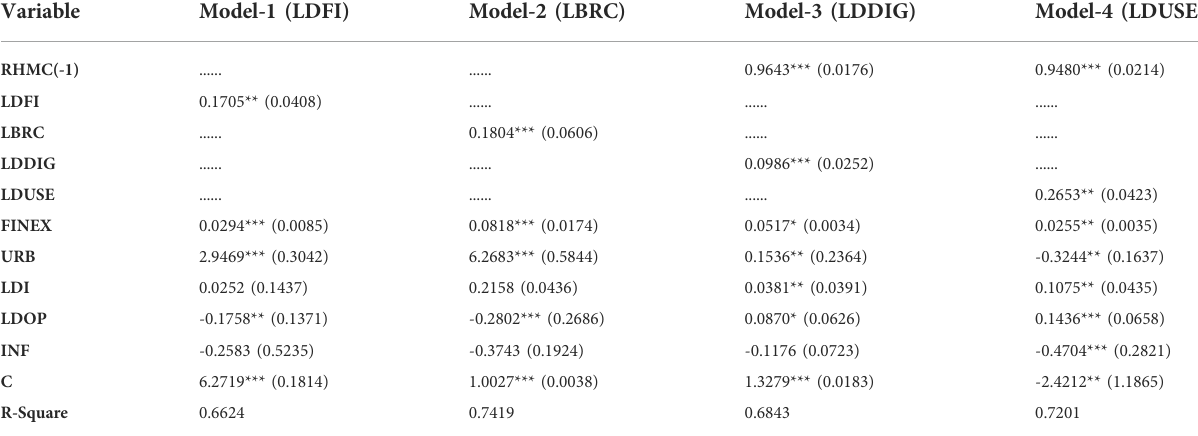
TABLE 6 Robustness